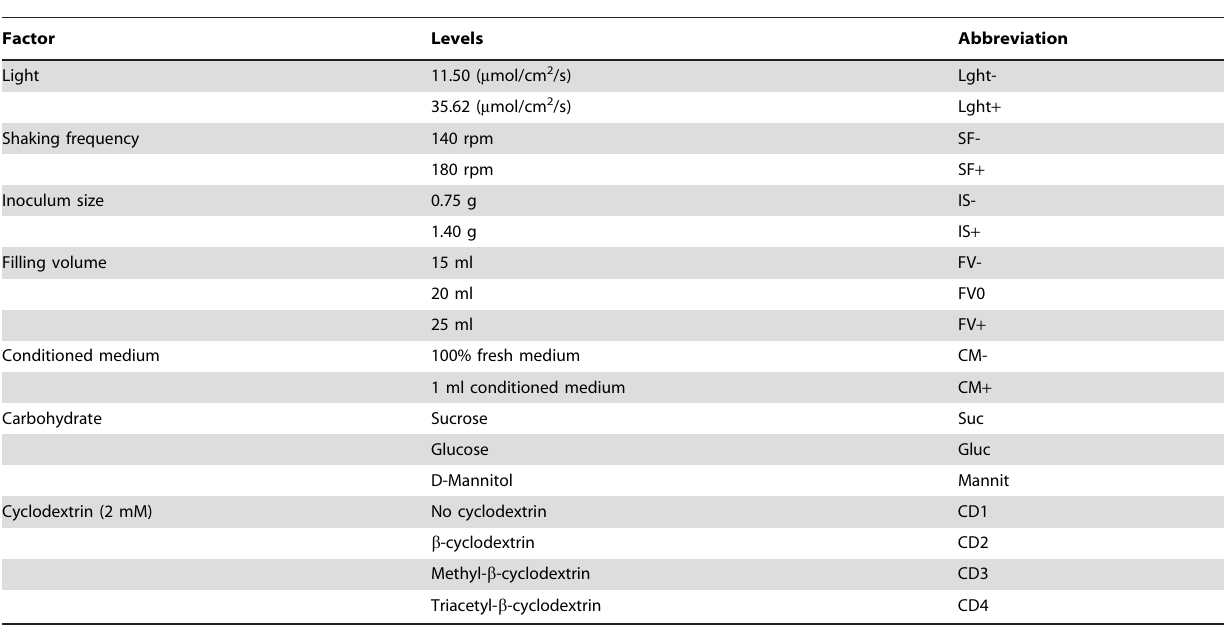
Table 1. Levels of the screened factors.